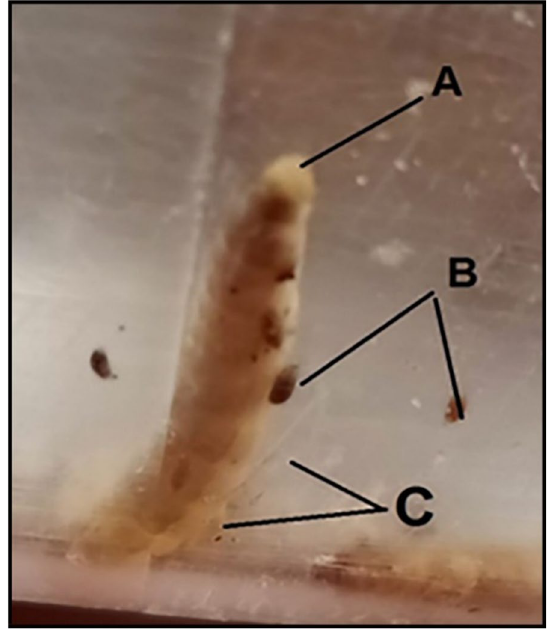
Fig. 1 Photomicrograph demonstrates A full grown larva of Corcyra cephalonica ; B Parasitoid Bracon hebetor larva; C Threads of formed cocoon